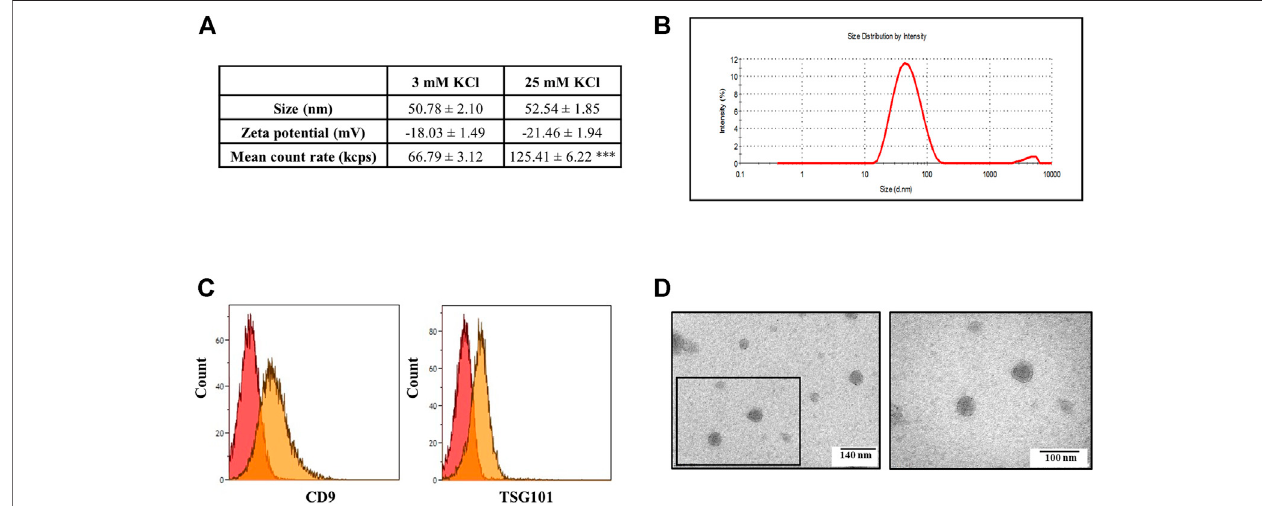
FIGURE 3 | Characterization of the exosomes released from cortical synaptosomes by light dynamic scattering, fl ow cytometry, and transmission electron microscopy (TEM). (A) Size (nM), zeta-potential (mV), and mean count rate (kcps) values detected using a Zetasizer Nano ZS90 particle sizer during the analysis of the exosomes isolated from the supernatants of the control (3 mM KCl) and depolarized synaptosomes (25 mM KCl). Data represent the mean ± SEM of n (cid:1) 5 (control synaptosomes) and n (cid:1) 7 (depolarized synaptosomes) analyses. *** p < 0.001 vs. the mean count rate value of 3 mM KCl. (B) Size distribution of the exosomes assessed using aZetasizer NanoZS90 particlesizer. Thecurve isrepresentative ofthe analysisof n (cid:1) 8exosomal preparations. (C) Flow cytometricanalysisofTSG101 and CD9expression intheexosomes puri fi edfrom thesupernatants ofdepolarizedsynaptosomesand coated onlatexbeads. Images arerepresentativeoftheanalysis of n (cid:1) 5 exosomal preparations. (D) Negative-stained exosomes isolated from the supernatants of depolarized synaptosomes observed by TEM. The left image shows theround and smoothmorphologyofisolatedexosomes, and therightpicture representsanenlargement(squared box)oftheoriginalimage. Theelectron micrographs are representative of n (cid:1) 5 exosomal preparations. Scale bar right: 140 nm; scale bar left: 100 nm.